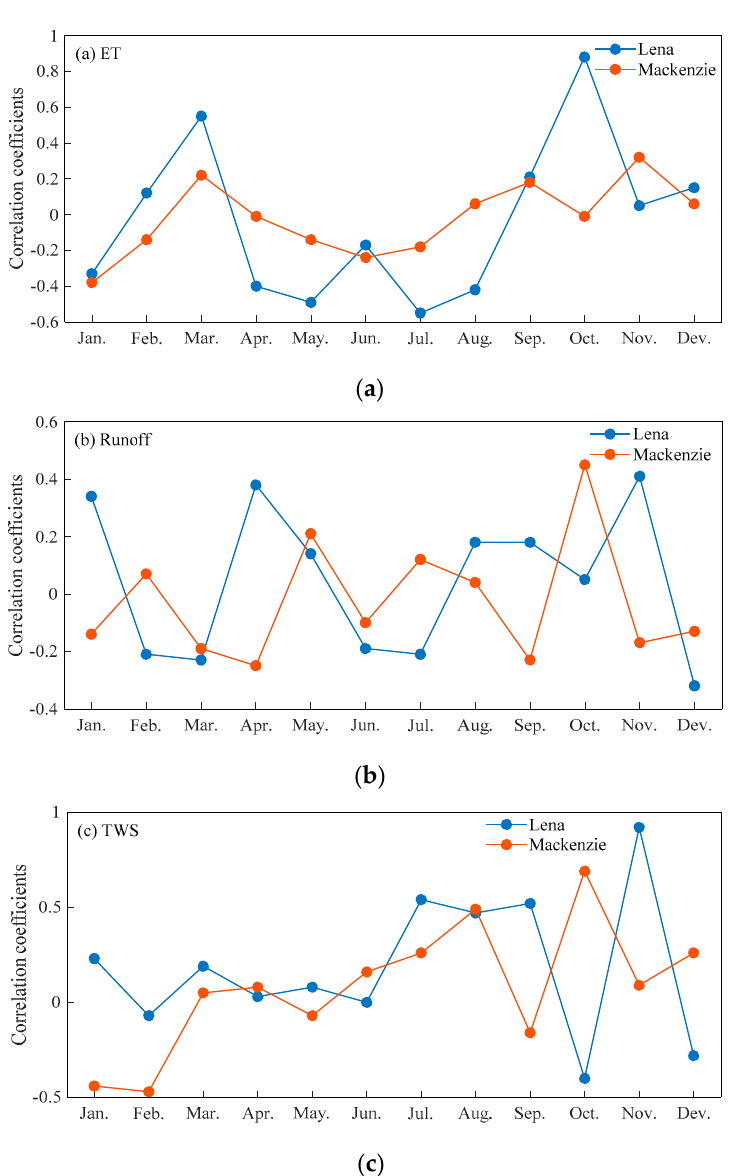
Figure 9. The relationships between the monthly precipitation and ET ( a ), runoff ( b ) and TWS ( c ) in the LRB and MRB.